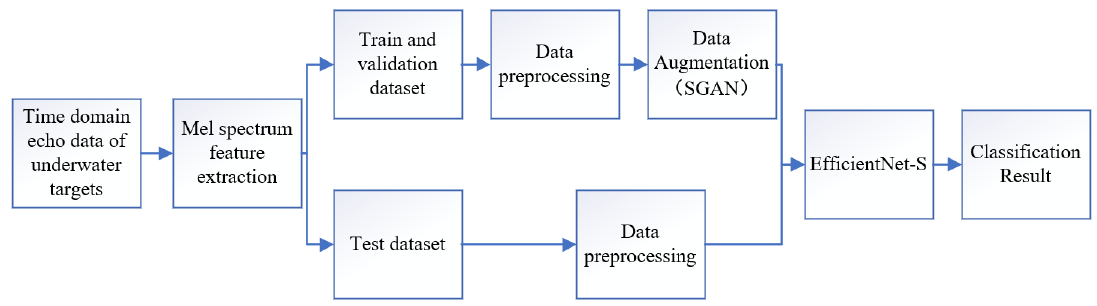
Figure 1. The structure of the proposed classification